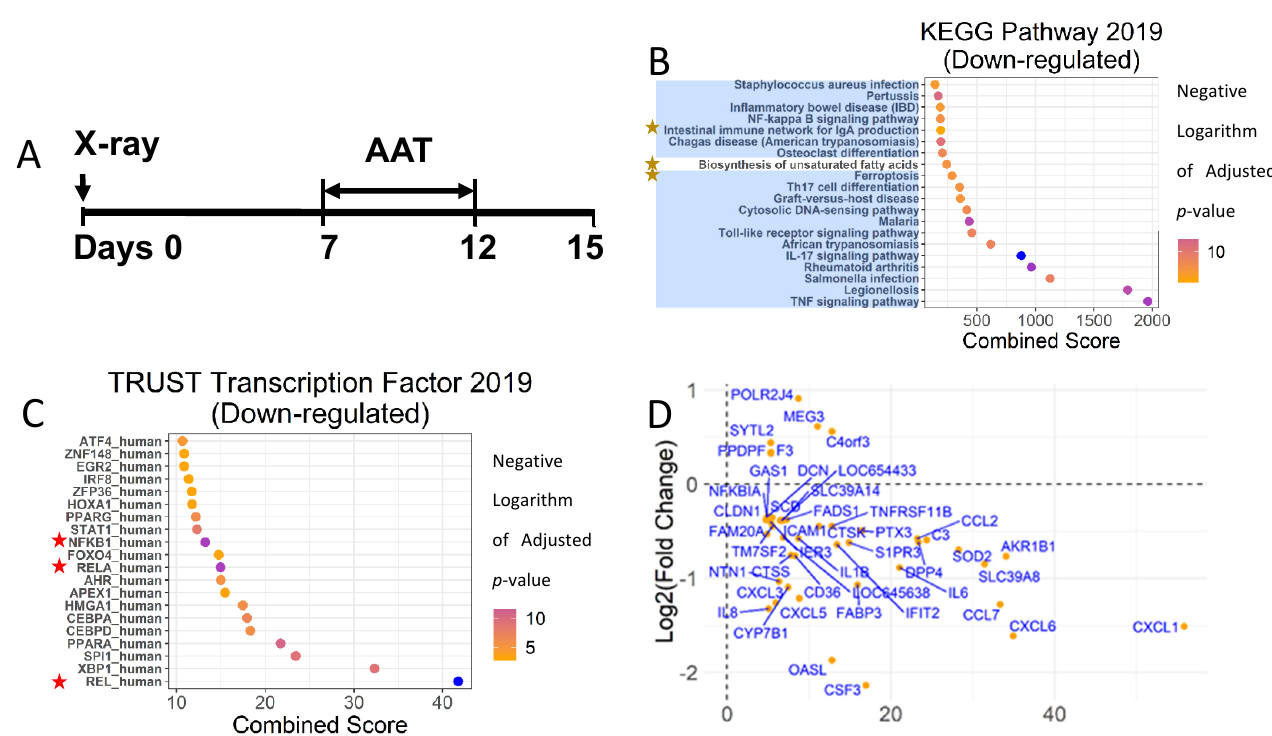
Figure 1. Human AAT suppressed NF- κ B-mediated inflammatory pathways in senescent HCA2 cells. ( A ) Study strategy: the HCA2 cells were irradiated and cultured without any interference for 7 days and then treated with hAAT (2 mg/mL) or 1× PBS containing fresh medium for 5 days. At day 12, FBS-free medium was used to replace the hAAT- or PBS-containing medium and culture the cells for 3 days. Total RNA was extracted at day 12 or 15 and processed for RNA-seq or PCR. ( B ) Pathway enrichment analysis using KEGG Pathway 2019 Gene Set. Blue shade: pathways related to inflammation; yellow star: pathways not regulated by NF- κ B. ( C ) Transcription factor enrichment analysis using TRUST Transcription Factor 2019 Gene Set. Red star: NF- κ B subunits. ( D ) The DEGs were identified by an adjusted p -value less than 0.01. The log2 (fold change) of DEGs were plotted against-log (adjusted p -value). The combined score was the combination of the Fisher’s exact test p - value and deviation from the expected rank of each term. The p -value, adjusted p -value, and com-